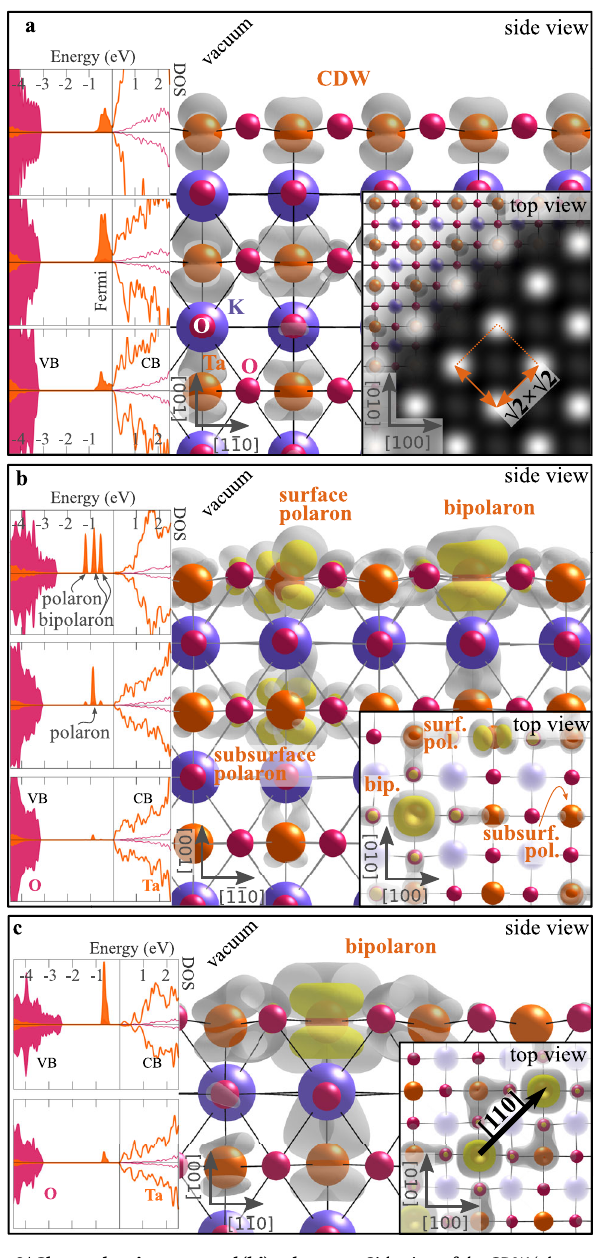
Fig.3|Chargedensitywaveand(bi)polarons.a SideviewoftheCDW(electronic chargerepresentedbygraycloud);insetsshowthespin-resolvedDOSprojected ontheTaO 2 layers(arbitraryunits),thetopview,andthesimulated fi lled-stateSTM signal.Sideview,topview,andDOSforthemixedcon fi gurationofsingle-electron polaronsandbipolarons( b )andthebipolaron[110]arrangement( c ).Yellowand graycolorsrepresentthepolaronicchargedensityathighandlowisosurface